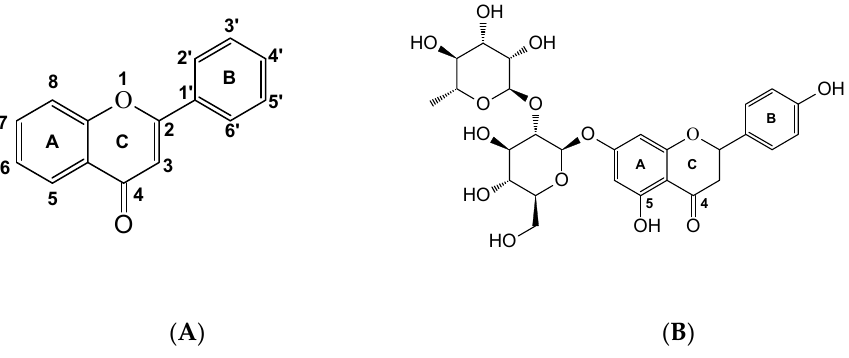
Figure 1. ( A ) Flavone structure. ( B ) Naringin structure.